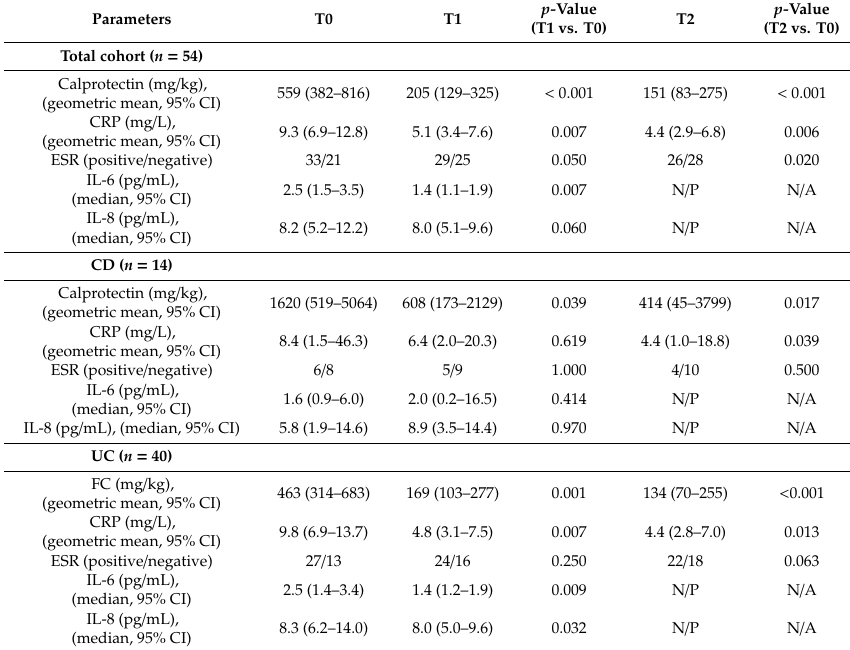
Table 3. Trend of the parameters at 3 and 12 months in the overall cohort and according to type of disease (CD and